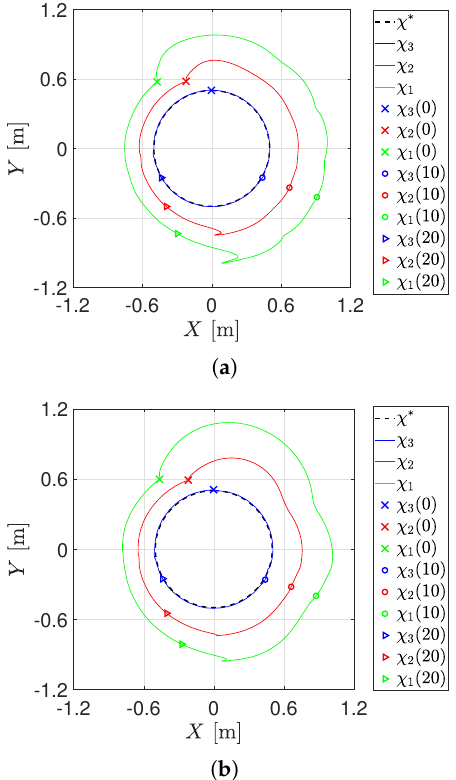
Figure 11. Trajectory in the plane of the mobile robots for the second experiment. ( a ) Trajectory in the plane with the GPIO approach. ( b ) Trajectory in the plane with the PI